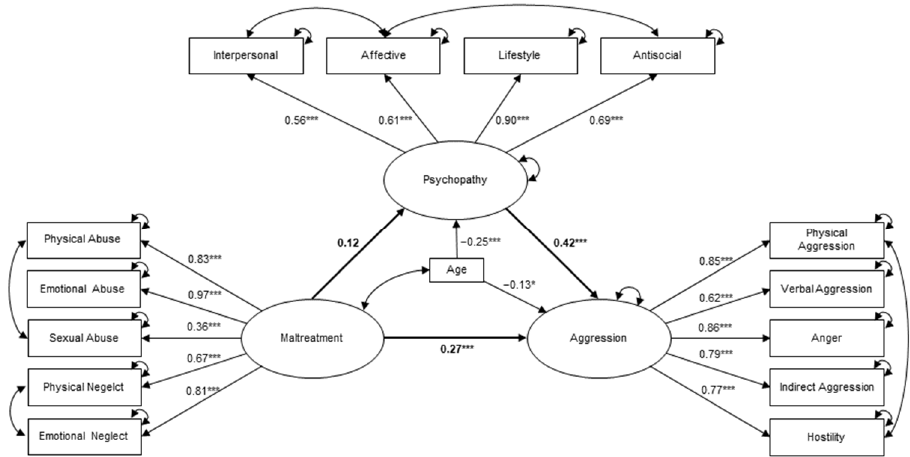
Figure 1. Final SEM on the associations between maltreatment, aggression, and psychopathy under the control of age. One-directional arrows show regression paths, bi-directional arrows show covariances. Standardized effects for the total sample are indicated with *** p < 0.001 and * p < 0.05.